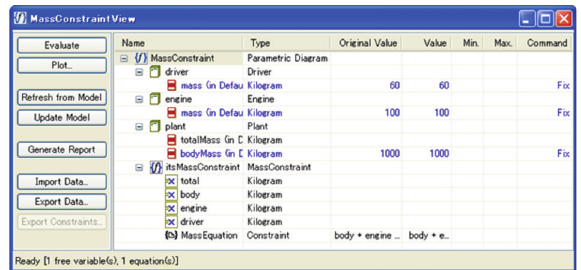
Figure 14: Constraint view window for evaluating the parametric diagram.